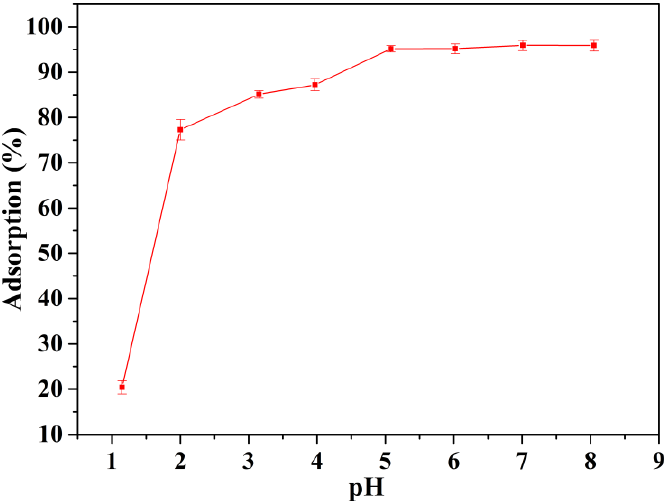
Figure 4. Effect of pH on Pb 2+ adsorption of the Alg-Mel. (~100 mg of Alg-Mel was equilibrated with 40 mL of 0.48 mM Pb 2+ at 25 °C for 6 h).